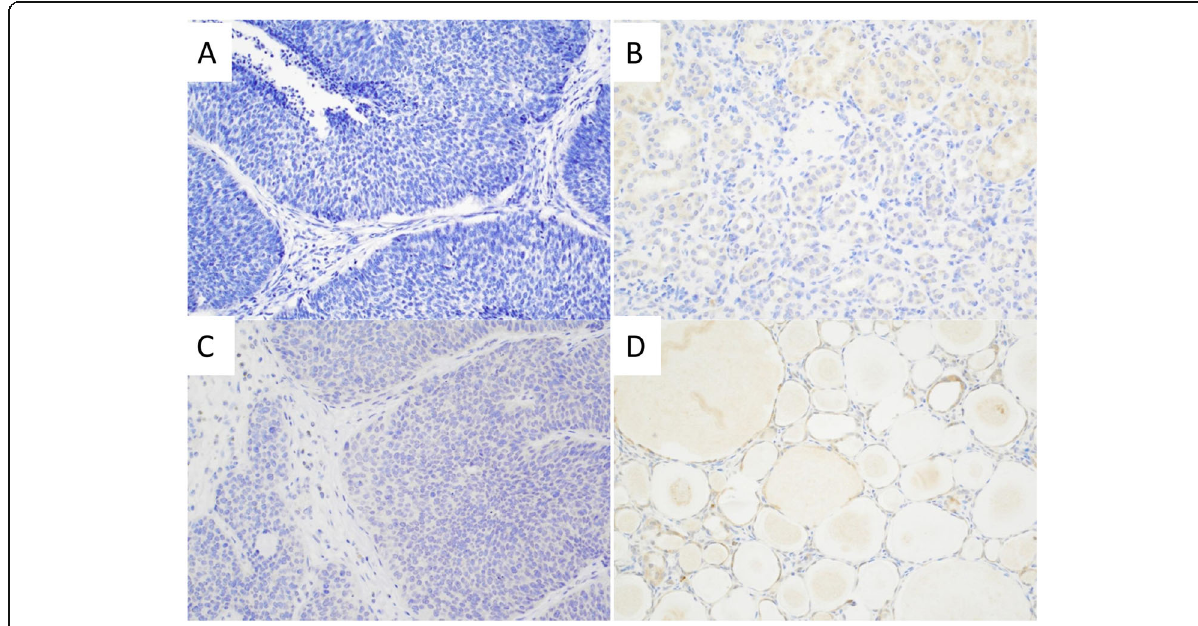
Fig. 3 Immunostain for BK virus is negative in the UC in the renal pelvis (A), donor kidney (B), bladder (C), and in the non-neoplastic native kidney